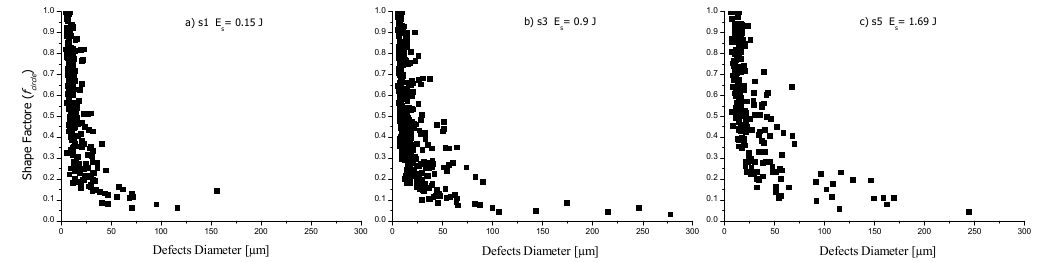
Figure 10. Defects diameter distribution as a function of shape factor for: ( a ) the lowest (s1), ( b ) the intermediate (s3) and ( c ) the highest value of deposition energy (s5).